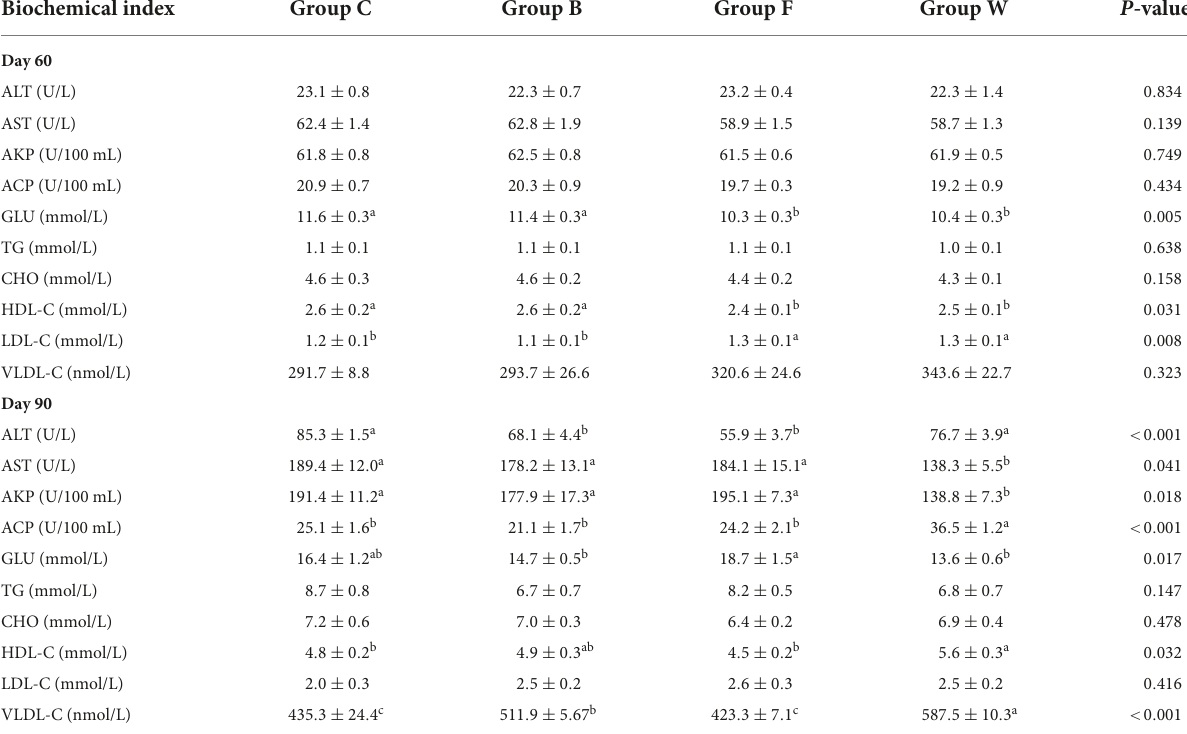
TABLE 3 Effects of brewers’ spent grain (BSG) on the serum biochemical indices in the four groups of Landes geese (i.e., groups C, B, F, and W) in 60 and 90 days. Biochemical